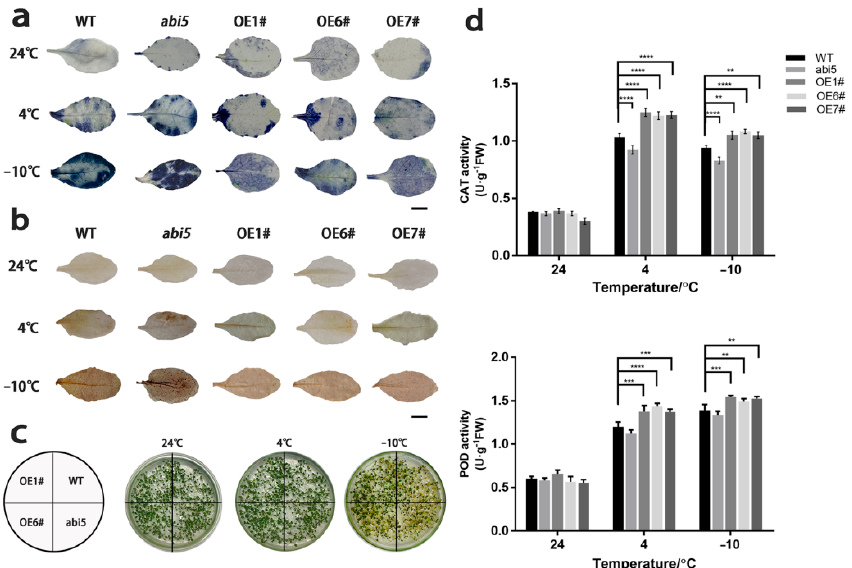
Figure 9. Overexpression of TaABI5 in A. thaliana enhanced tolerance to freezing stresses and ROS- scavenging ability. ( a ) Histochemical staining assays with NBT. ( b ) Histochemical staining assays with DAB. ( c ) The 2-week-old transgenic, wild type, and abi5 seedlings were exposed to freezing treatment. The plants were acclimated at 4 °C for 3 d, then treated at − 10 °C for 2 h, and restored to normal culture for 7 d. ( d ) CAT and POD of Arabidopsis lines under freezing stress. All values in the figure are mean ± SD ( n = 3), p values (versus WT) were corrected with ANOVA, ** p < 0.01, *** p < 0.001, and **** p < 0.0001.